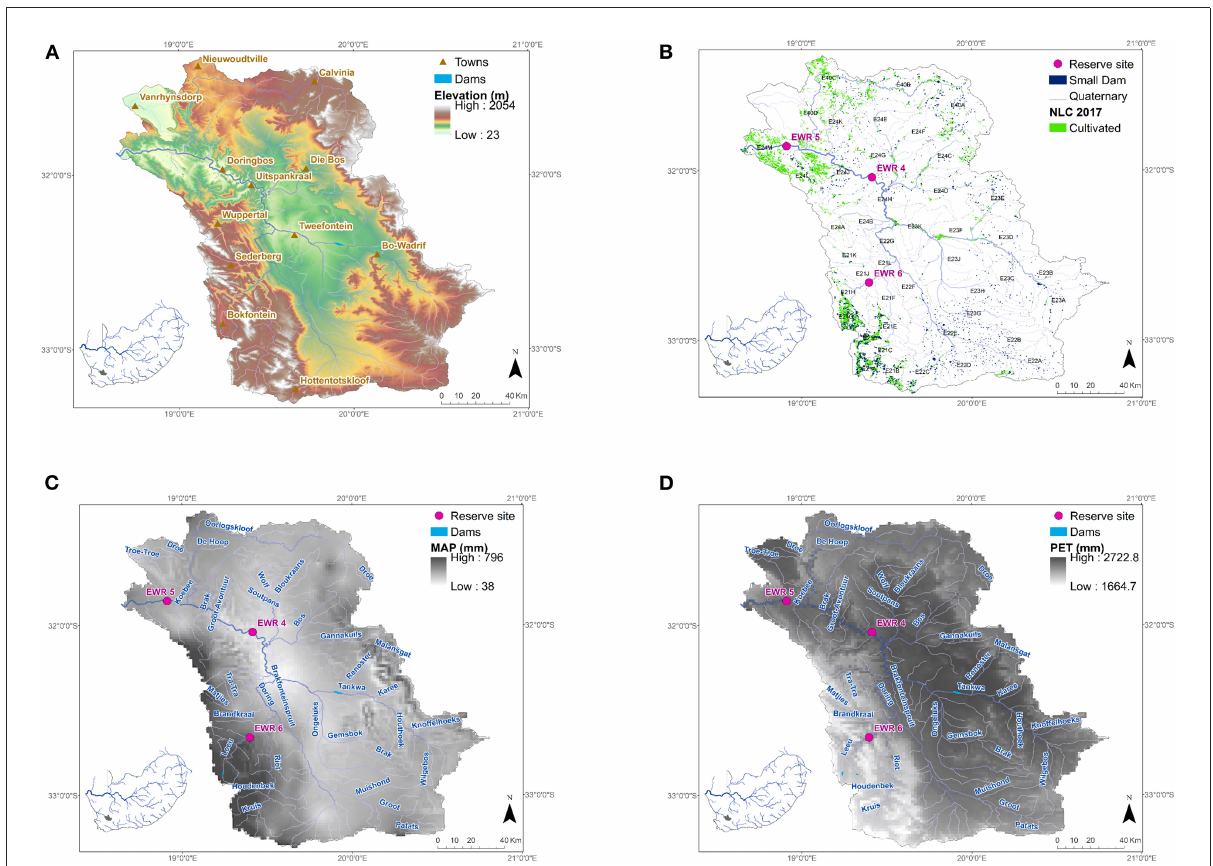
FIGURE1 Doring River catchment showing (A) the elevation and location of rivers and towns, and (B) the location of cultivated areas [obtained from 2017 National Land Cover; Department of Environmental Affairs (2018)], the quaternary catchments (fourth-order primary management areas) and